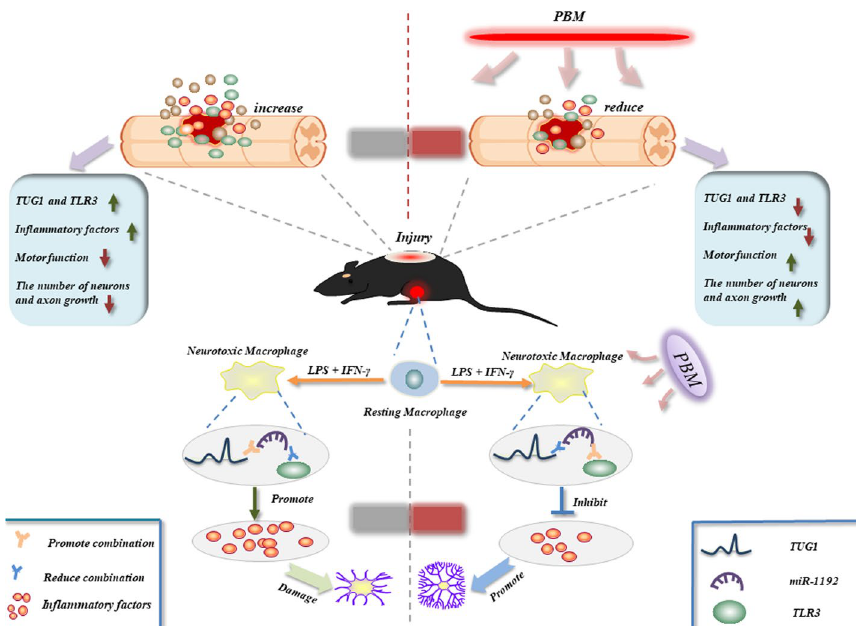
Fig. 9 Schematic diagram showing the potential mechanism of PBM to promote SCI repair. At the cellular level, the expression of lncRNA TUG1 increased after the induction of M1 macrophages, which promoted the polarization and inflammatory response of M1 macrophages and aggravated neuronal damage. In mechanism, tug1 can promote TLR3 expression by adsorbing miR-1192, while PBM inhibits this pathway. PBM reduced the expression of TUG1, TLR3 and inflammatory cytokines in spinal cord tissue, and promoted the recovery of motor